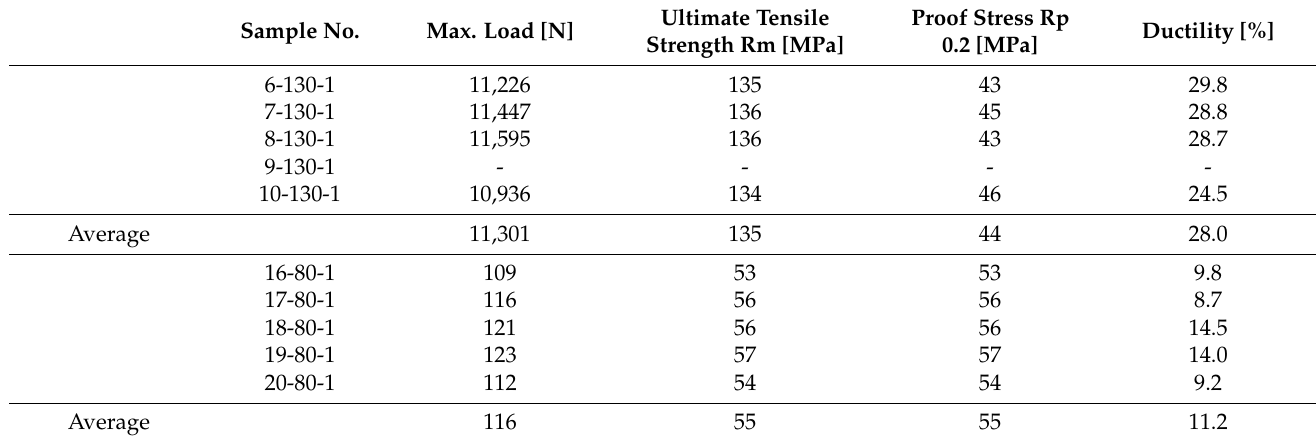
Table 2. Average values of the mechanical parameters of samples with integrated RFID tag type no. 1. Sample